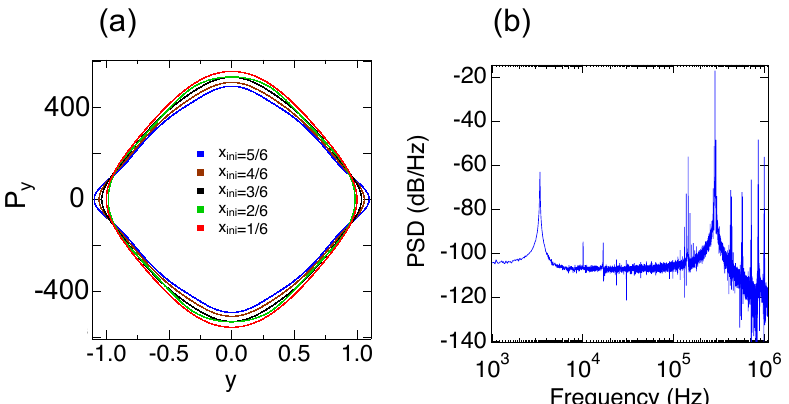
Figure 2. ( a ) Poincare section of the Py of the particle at ( x 0 , p x 0 , y 0 , p y 0 ) = ( x ini ,0, w c ,0 ) with (cid:16) (cid:17) i x ini = L , i = 1, . . . ,5. The momentum is in units of fg/s and y in units of w c . ( b ) Power spectral 2 6 density spectrum for the y component of the position of the particle for x ini = L